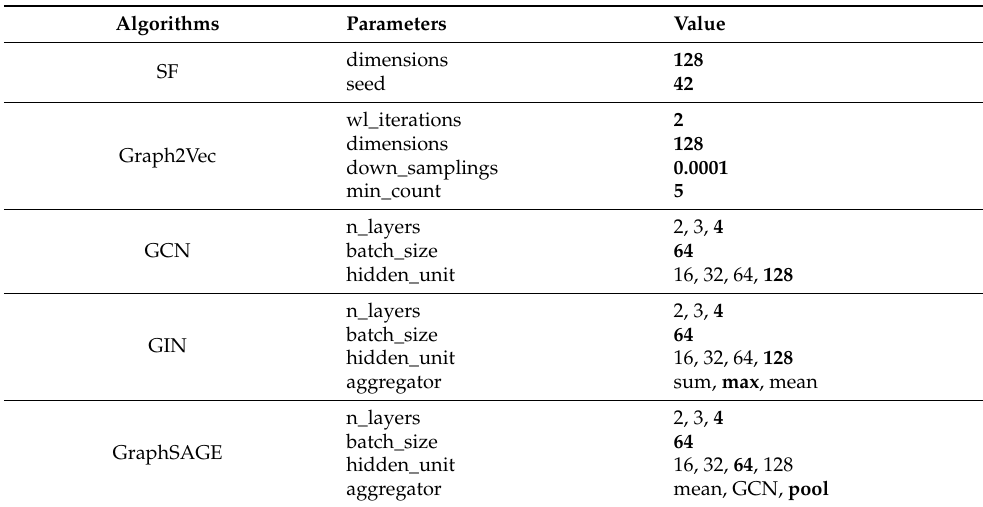
Table 3. The candidates of the parameters. The best parameters based on the AUROC are indicated in